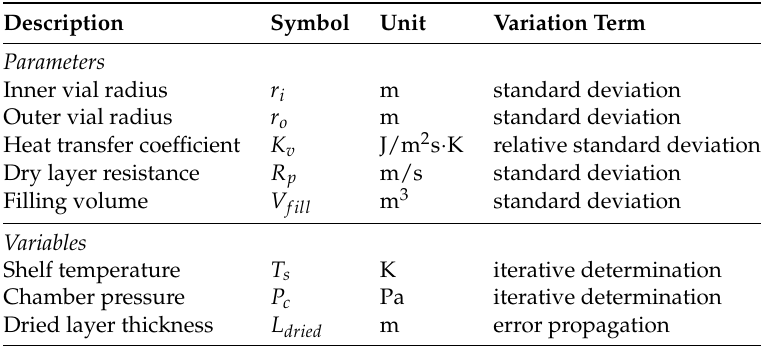
Table 1. Sources of uncertainty in the primary drying model together with the methods used to take into account their